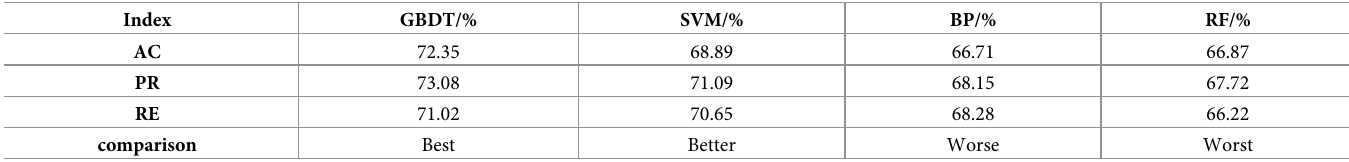
Table 7. Disturbance information extraction performance comparison for algorithms with different classification